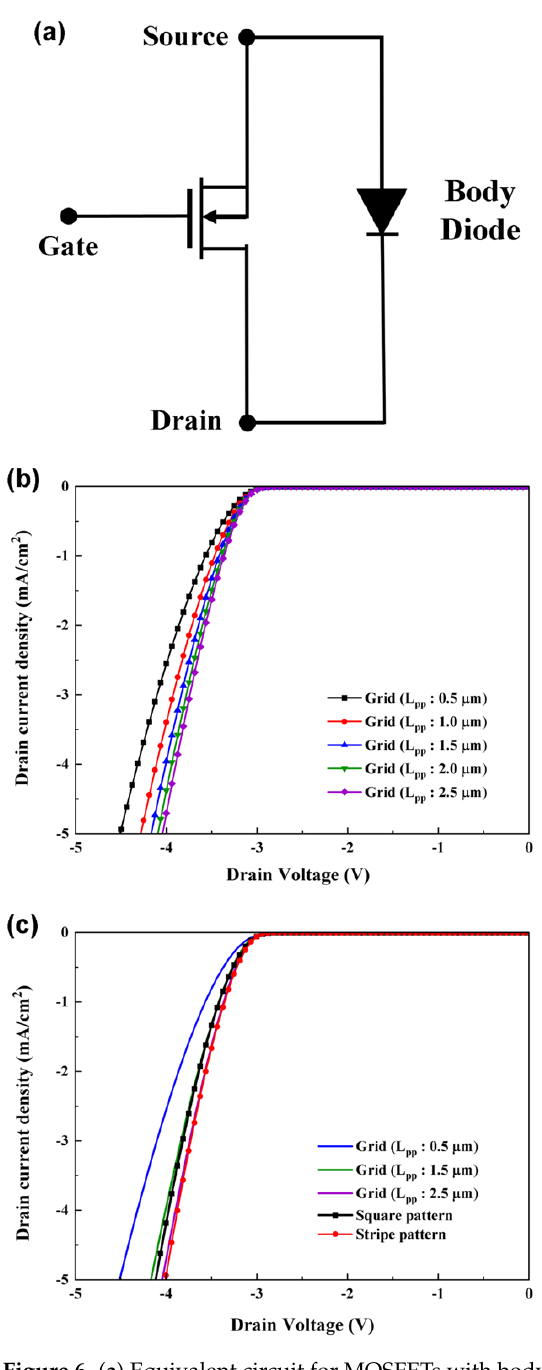
Figure 6. ( a ) Equivalent circuit for MOSFETs with body diode; ( b ) third-quadrant behaviors for grid pattern with L pp of 0.5~ 2.5 μm; ( c ) third-quadrant behaviors of square, stripe, and grid pattern with L pp of 0.5 μm, 1.5 μm, and 2.5 μm.